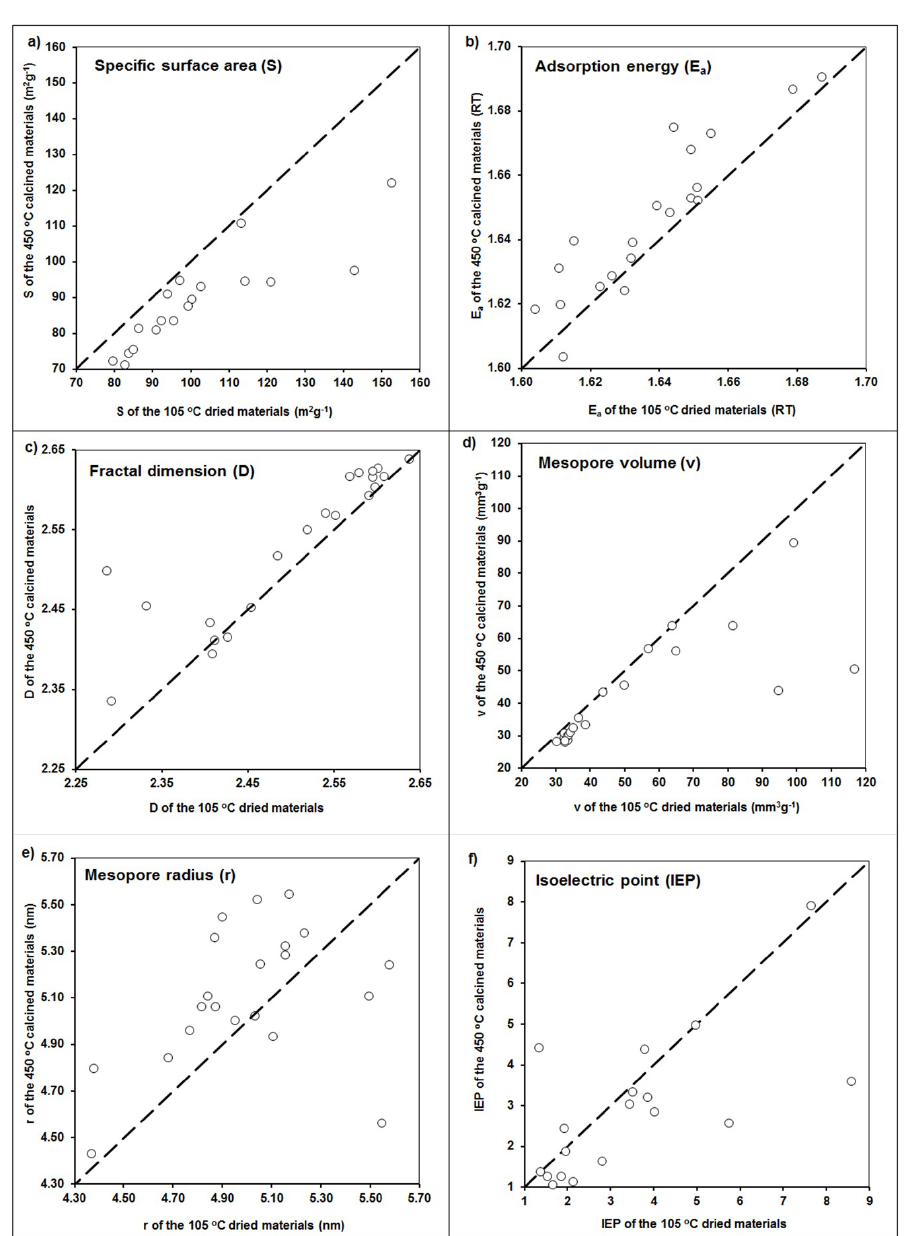
Figure 4. Changes in ( a ) specific surface area, ( b ) adsorption energy, ( c ) fractal dimension, ( d ) mesopore volume, ( e ) mesopore radius, and ( f ) isoelectric point values after calcination of the studied materials. Dashed lines are 1:1 dependencies.